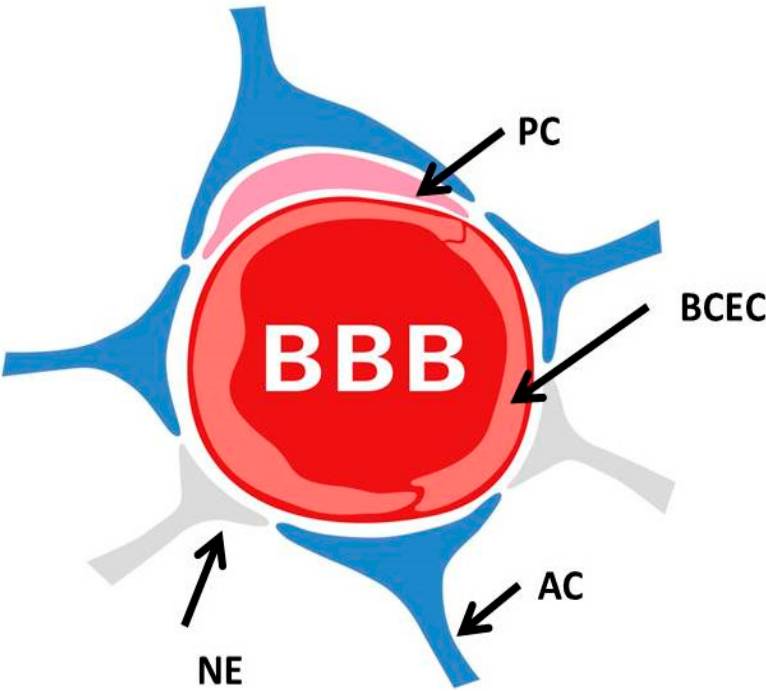
Figure 1. The blood–brain barrier. The blood–brain barrier is formed by endothelial cells of the capillary wall (BCEC: brain capillary endothelial cells), astrocyte (AC) end‑feet surrounding the capillary and pericytes (PC) embedded in the capillary basement membrane. This system allows the selective passage of nutrients while restricting the entry of potentially neurotoxic compounds. NE: neuronal end-feet.